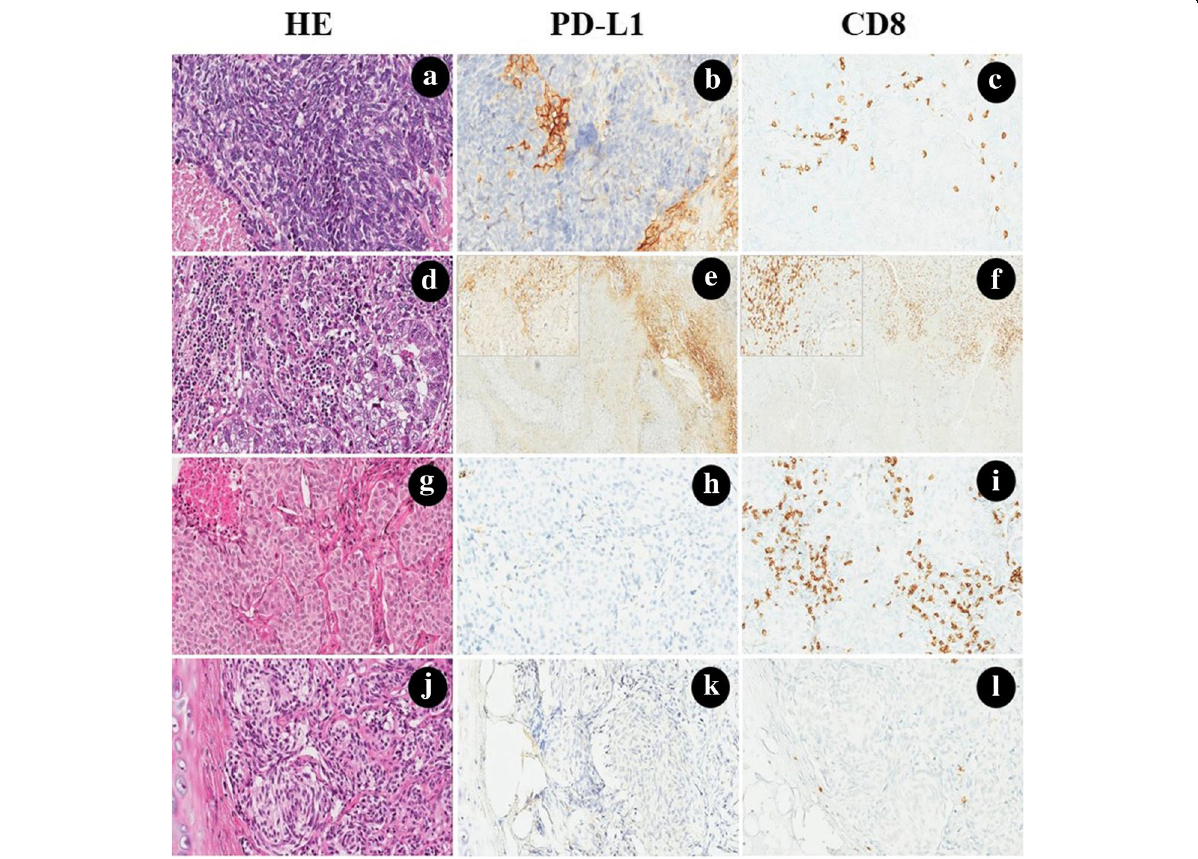
Fig. 1 Hemotoxylin and eosin (H&E), PD-L1 and CD8 stains, each performed on histologic sections of small cell lung cancer ( a - c ), large cell neuroendocrine carcinoma ( d - f ), atypical carcinoid ( g - i ) and typical carcinoid ( j - l ). a Small cell lung cancer was showing a scant cytoplasm, fine nuclear chromatin, absent or inconspicuous nucleoli, extensive necrosis. b PD-L1 was moderately expressed on the membrane of stromal immune cells in the desmoplastic stroma between clusters of tumor cells. c CD8+ TILs were observed in the stroma, while the intratumoral pattern of CD8 expression was not common. d Large cell neuroendocrine carcinoma with prominent nucleoli and abundant eosinophilic cytoplasm, necrosis was not shown. e , f PD-L1 was positively expressed on the membrane and cytoplasm of the immune cells, and a large number of CD8+ TILs could also be observed at the borderline (the 200× magnification for PD-L1 and CD8 was shown in the upper left, respectively). g Atypical carcinoid with vascularized stroma, focal necrosis and 6 mitosis/2 mm 2 . h , i PD-L1 was negative expression either in tumor cells or stromal cells, while CD8+ TILs were exhibited in the interface of tumor and stroma. j Typical carcinoid with organoid growth pattern with intervening vascular stroma. k , l No PD-L1 can be detected, and only several CD8+ TILs could be found in the stroma. (The original magnification of e-f was 100×, magnification for remaining cases were